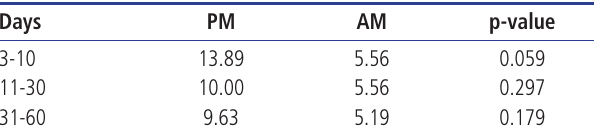
Table 4. The diarrhea rate of calves fed pasteurized and acidified milk ad libitum (%) Days PM